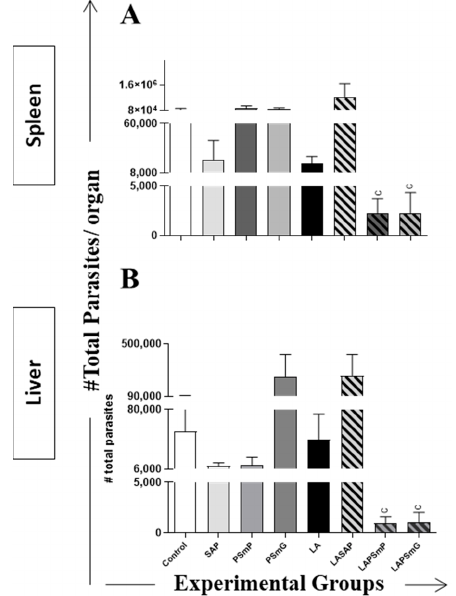
reduction in liver parasite load in relation to the control group ( p < 0.05) (Figure 4B).